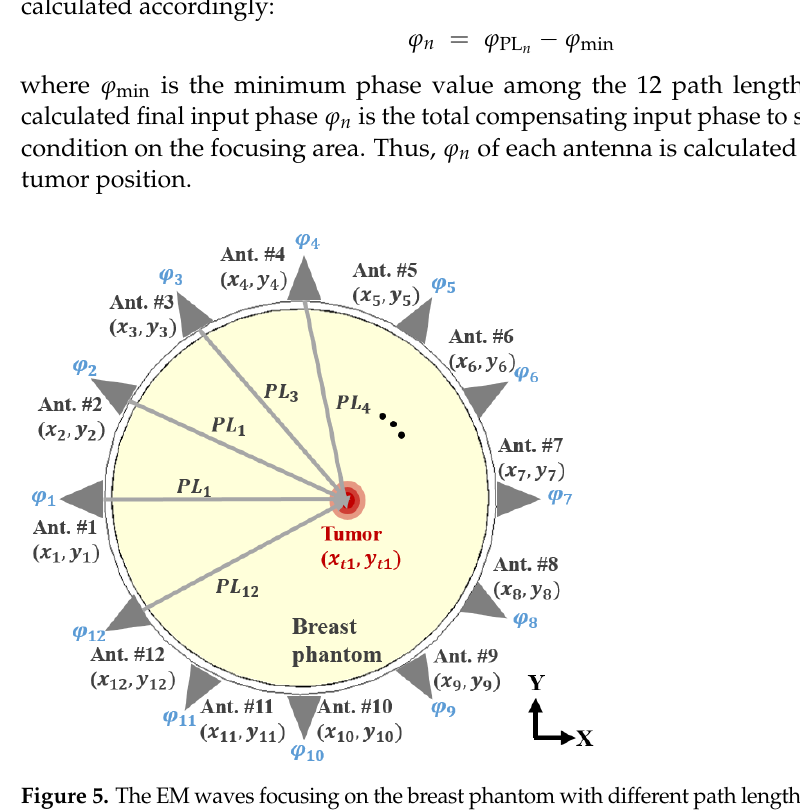
Table 1. Dielectric and thermal properties of breast tissues at 2.45 GHz [32].